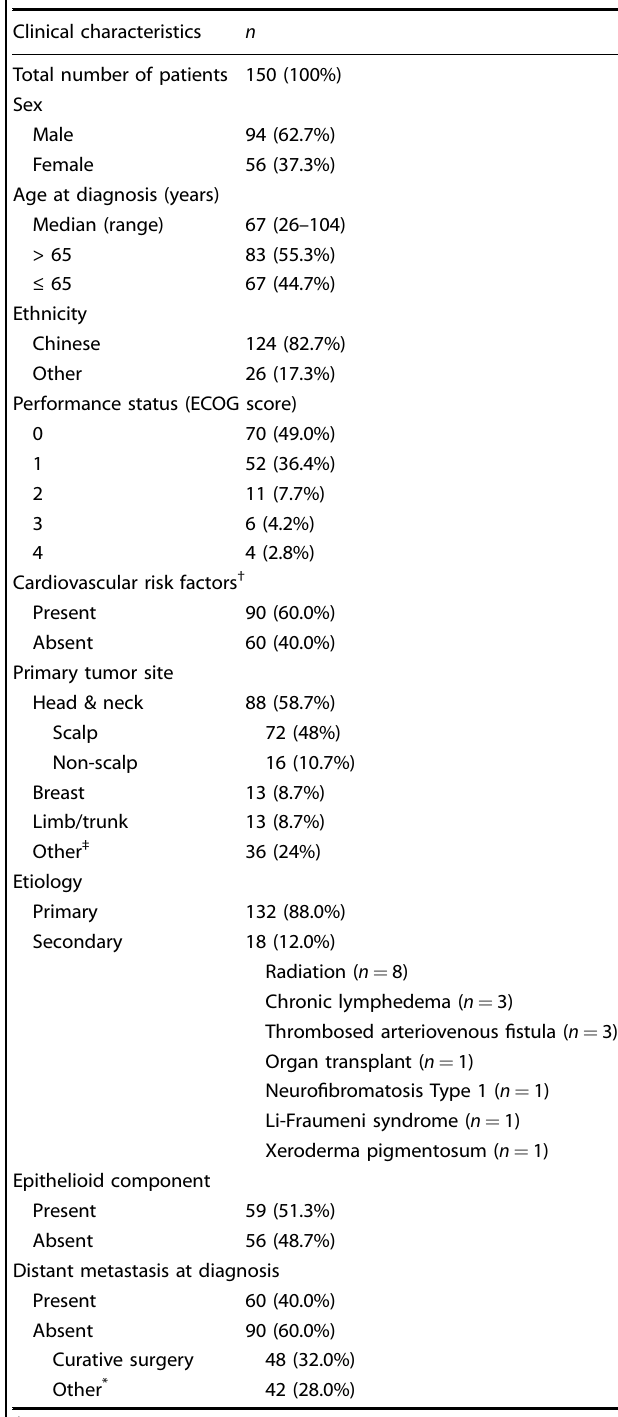
Table 1. Clinical features of patients with angiosarcoma included in the